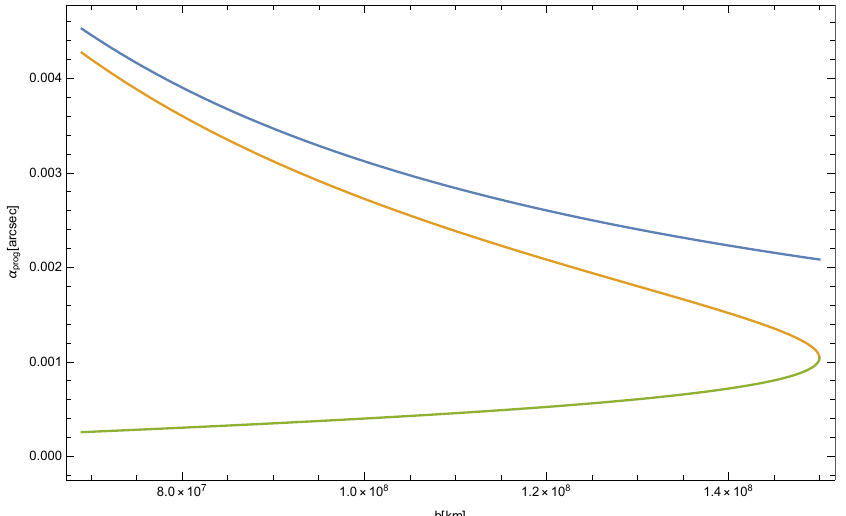
Figure 14. α in the Teo wormhole: The blue curve is the asymptotic deflection angle by the rotating Teo wormhole. The orange curve is the deflection angle with finite-distance corrections by the rotating Teo wormhole. The blue curve shows the difference between the asymptotic deflection angle and the deflection angle with finite-distance corrections by the rotating Teo wormhole.